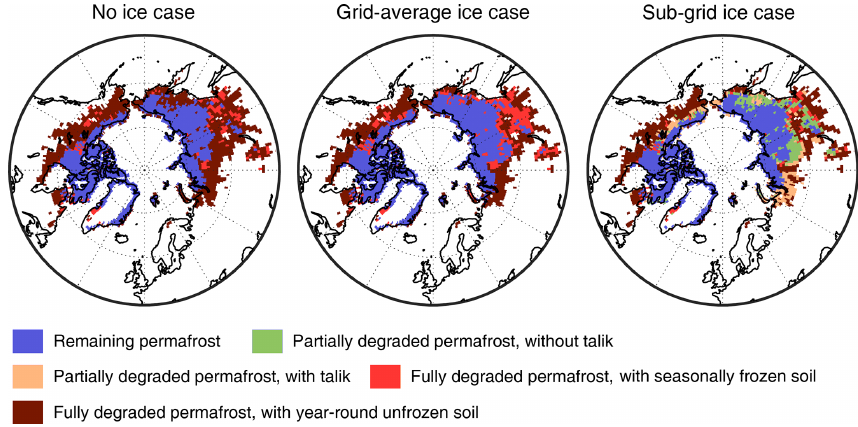
Figure 8. Maps of different stages of permafrost degradation diagnosed from the model output by the year 2100.